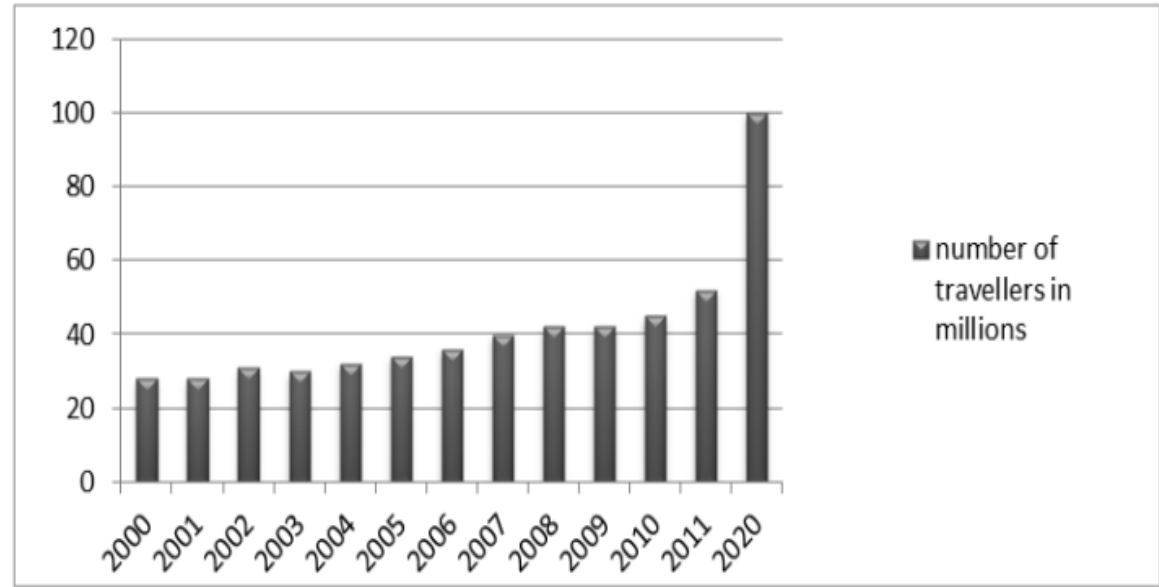
Figure 5. The number of travelers going through Saudi airports [79].